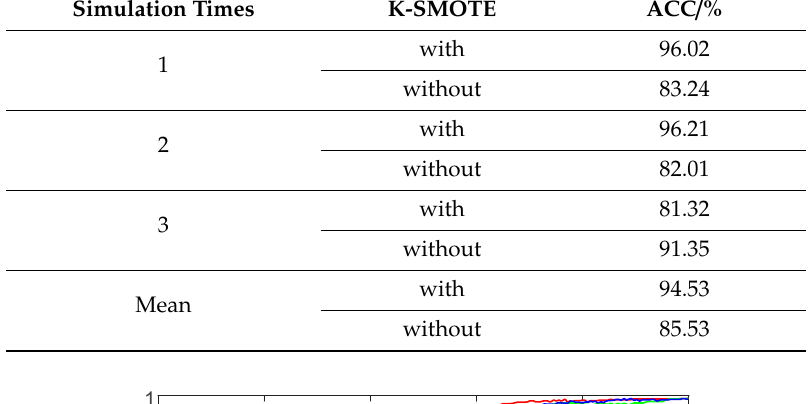
Table 4. Accuracy value of random forest.